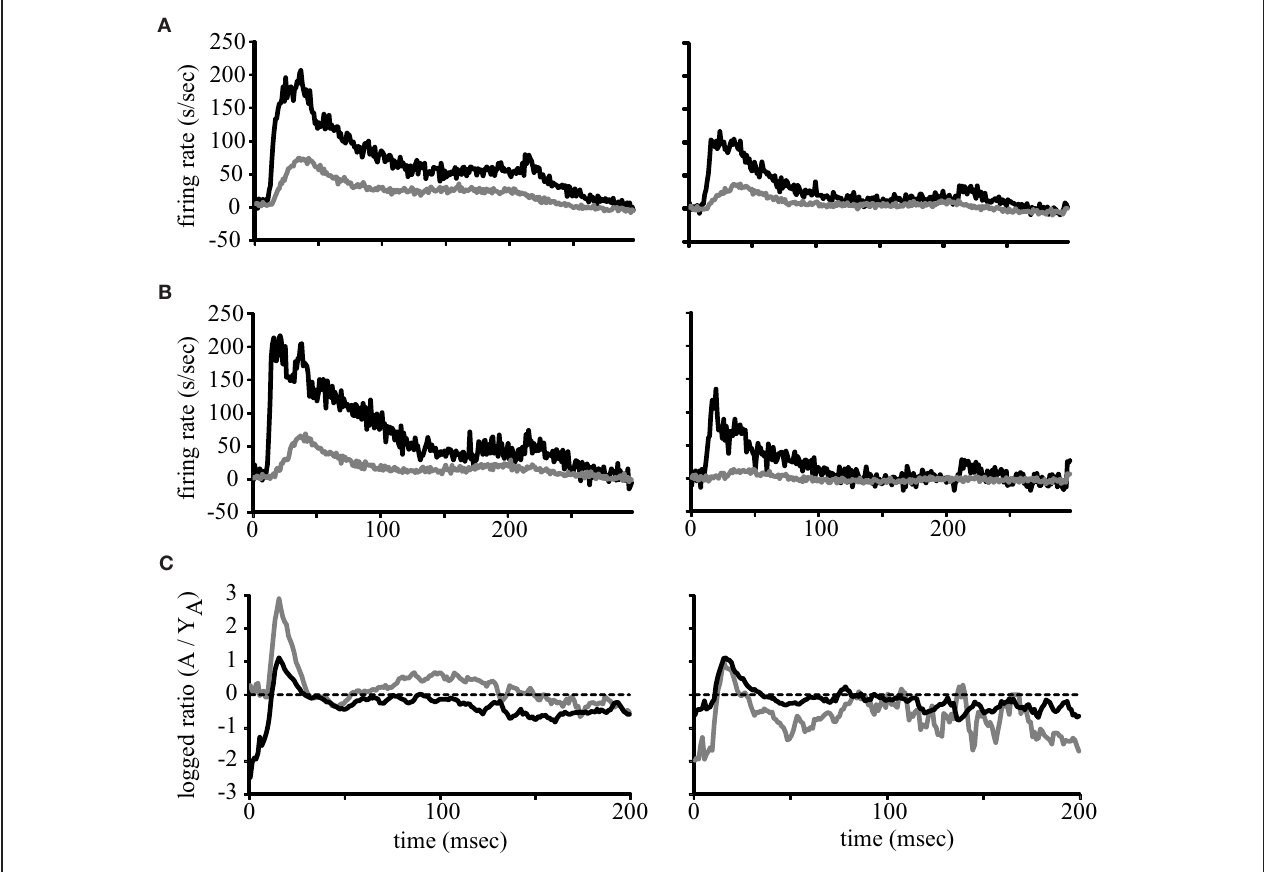
FIGURE 3 | Population firing rates. Each line represents the average firing rate across the population of neurons in young (gray lines) and aged (black lines) monkeys for A1 (A) and CL (B) . The response to the best direction is